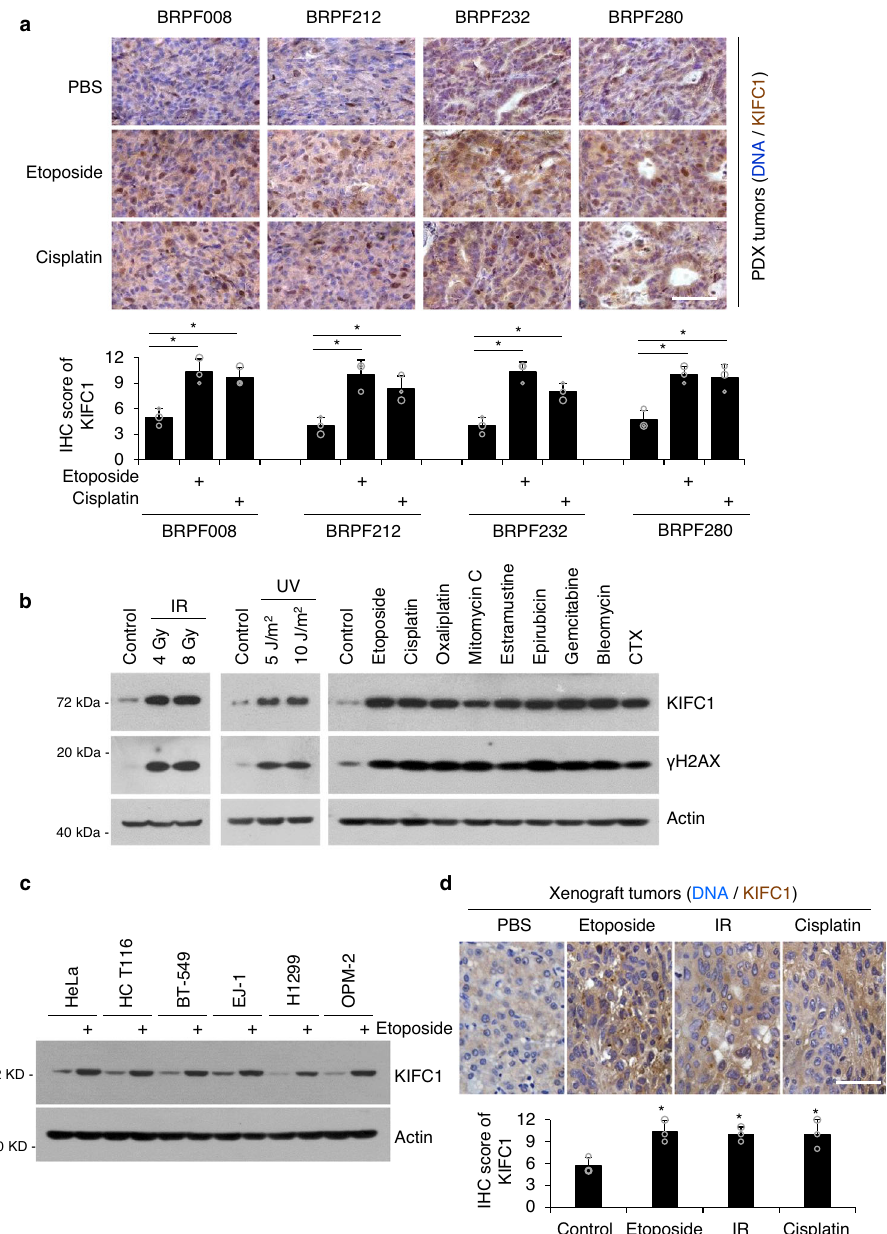
Fig. 2 DNA-damaging treatments induce the centrosome clustering protein KIFC1. a KIFC1 protein expression in PDX models after treatment with PBS, etoposide, or cisplatin. Data are representative of stained tumor tissues (scale bar, 50 μ m) with quantitative analysis. Two-tailed t test p values: p = 0.04721 (BRPF008, Eto), 0.0339 (008, Cis), 0.0350 (212, Eto), 0.0390 (212, Cis), 0.0341 (232, Eto), 0.0202 (232, Cis), 0.0263 (280, Eto), and 0.0130 (280, Cis). ( b, c ) MDA-MB-231 cells ( b ) or indicated cells ( c ) were treated with irradiation (IR), ultraviolet (UV) light, etoposide (10 μ M), cisplatin (10 μ M), oxaliplatin (40 μ M), mitomycin C (2 μ M), estramustine (20 μ M), epirubicin (0.5 μ M), gemcitabine (4 μ M), bleomycin (10 μ M), or cyclophosphamide (CTX, 10 mM) for 15 h. Cell lysates were immunoblotted with antibodies against KIFC1, γ H2AX, or β -actin (as the internal standard). d MDA-MB-231 xenograft tumors were treated with etoposide, IR, or cisplatin as described in the Methods section. Data are representative of stained tumor tissues (scale bar, 50 μ m) with quantitative analysis. Three tumors were included in each group. Two-tailed t test p values: p = 0.0424 (Eto), 0.0345 (IR), and 0.0415 (Cis). Data represent the mean ± SD of three independent experiments ( a, d ). * p < 0.05, ** p < 0.01, Source data are provided as a Source Data fi